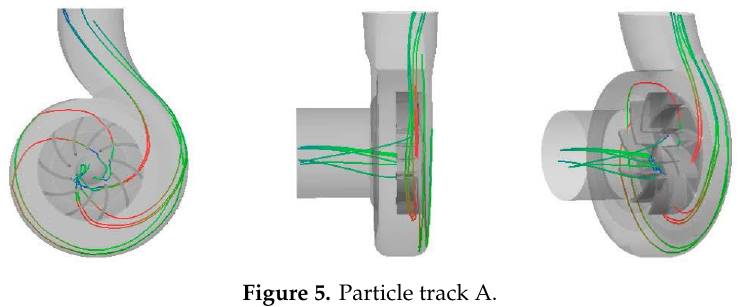
Figure 5. Particle track A.